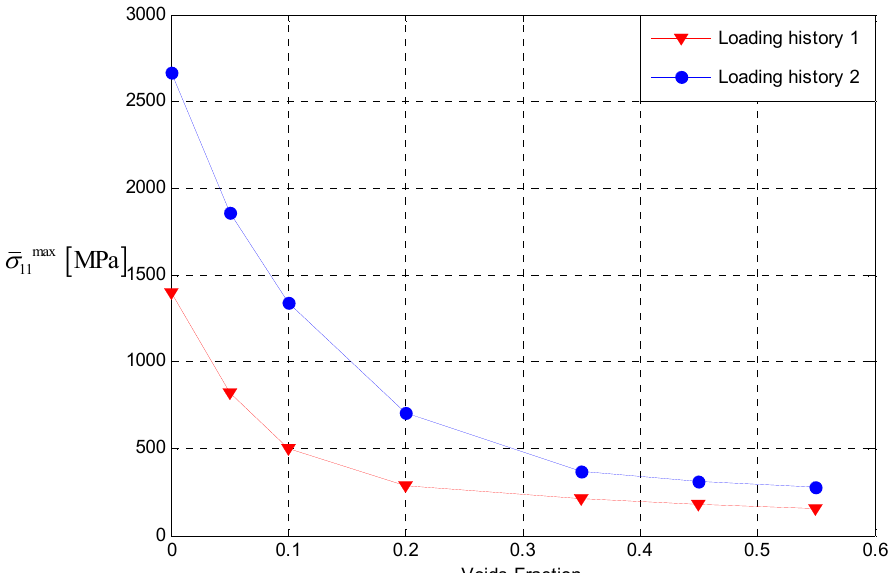
Figure 4: Maximum average normal stress for the considered porosities provided by the two loading histories.